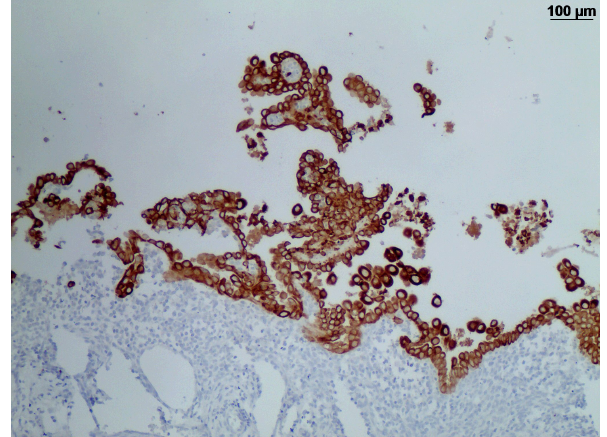
Figure 4. Immunohistochemistry of a reactive mesothelial hyper- plasia in an African green monkey: strong immunoreactivity of the mesothelial cells for cytokeratin.